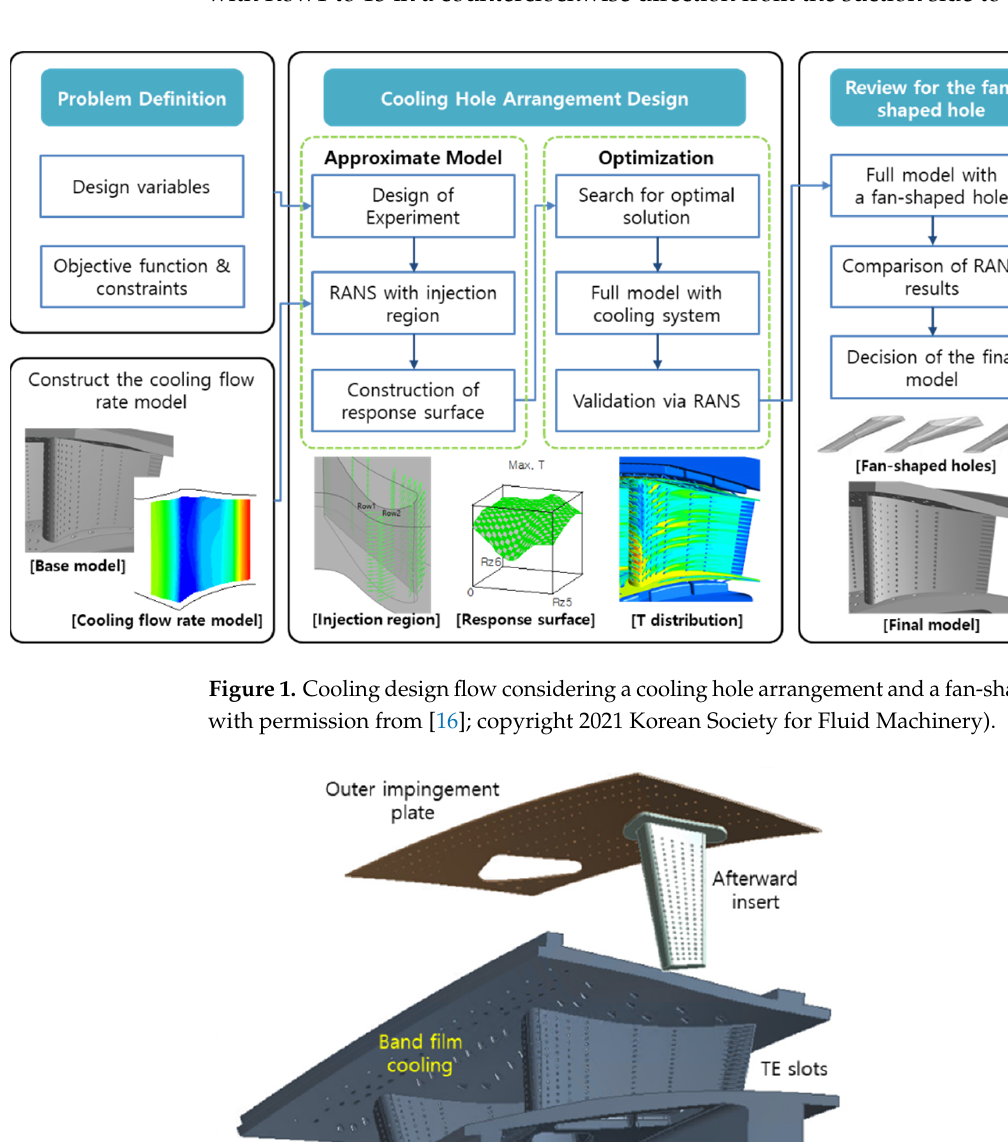
Figure 1. Cooling design flow considering a cooling hole arrangement and a fan-shaped hole (adapted with permission from [16]; copyright 2021 Korean Society for Fluid Machinery).